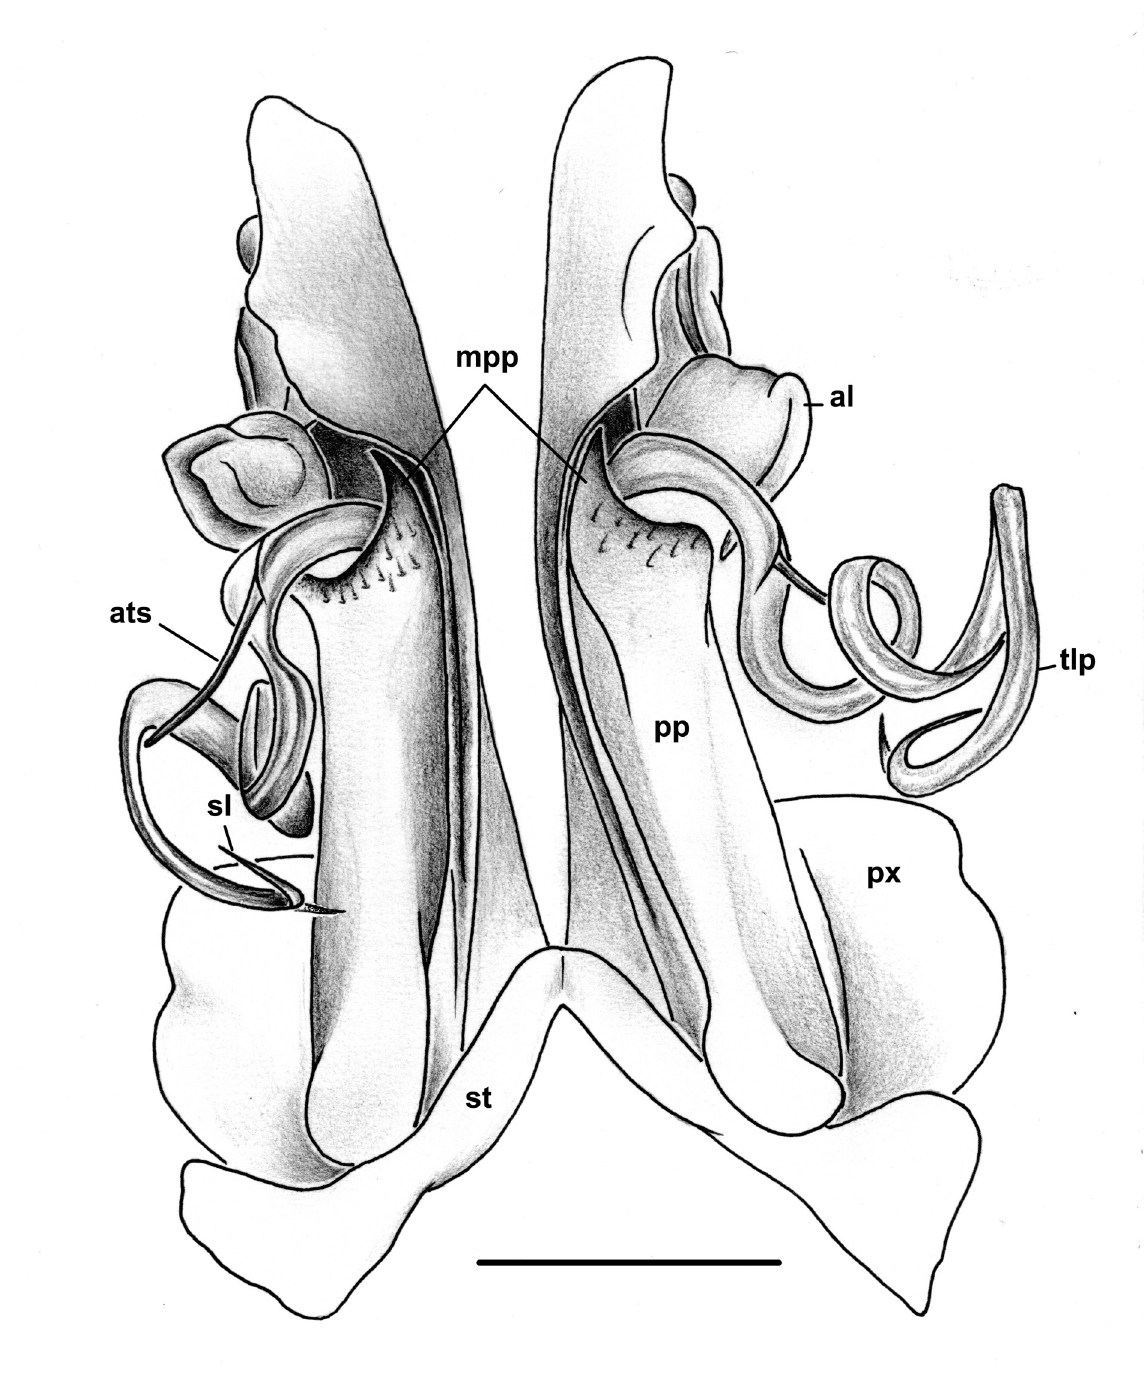
Fig. 6. Sechelleptus arborivagus sp. nov., paratype, ♂ (BE_RMCA_MYR.Dip.22875). Drawing of the gonopods, oral view. Abbreviations: al = apicolateral lamellose lobe; ats = antetorsal process; mpp = mesaplical projection; pp = proplica; px = paracoxite; sl = solenomere; st = sternite; tlp = telopodite. Scale bar = 1